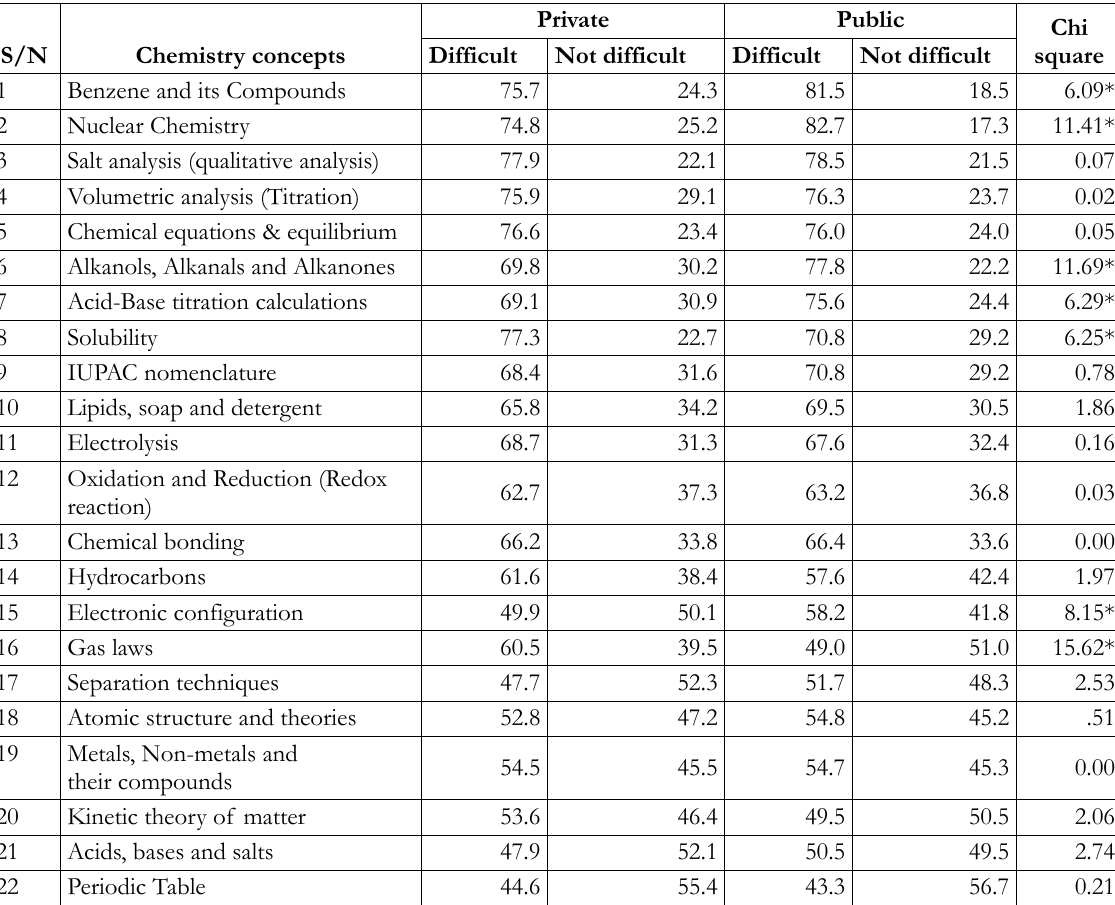
Table 4. Crosstabulation of perception of the difficulty of chemistry concepts by students in private and public